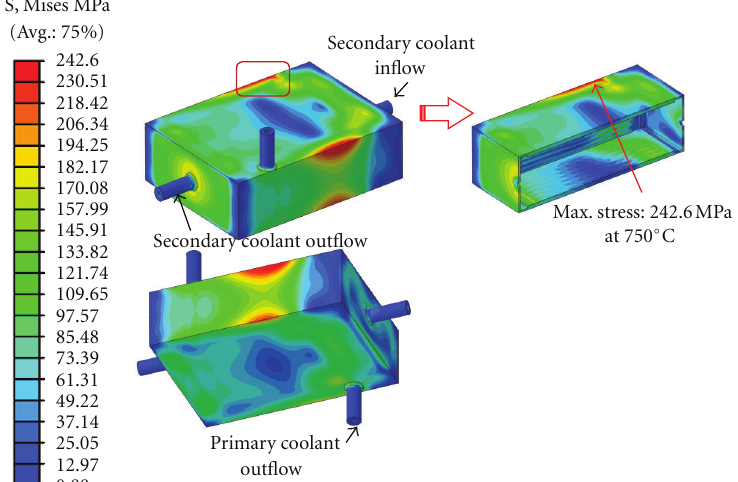
Figure 12: Overall stress contours of a 3kW class PHE prototype from an elastic-plastic analysis using the parent material properties [6].